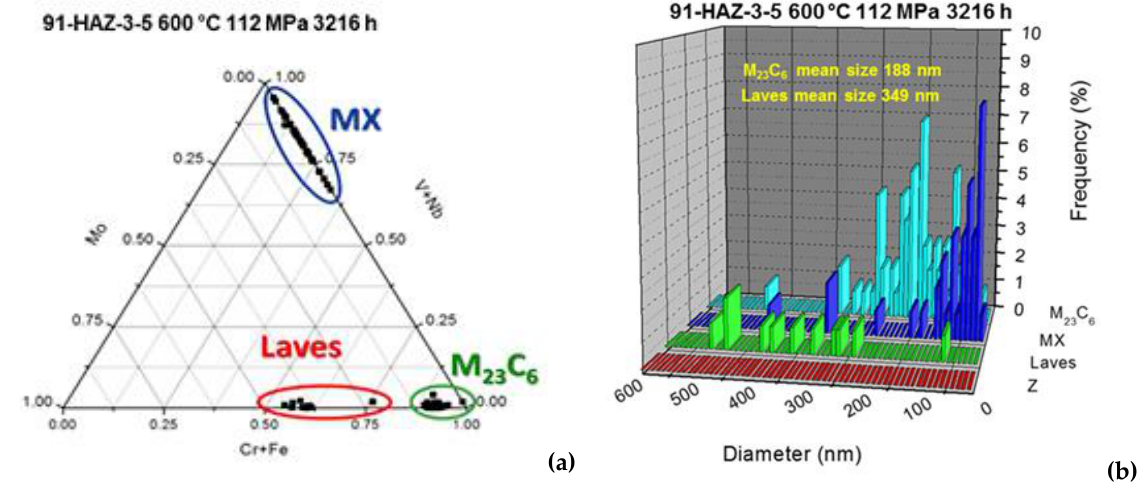
Figure A3. Failed crept cross-weld specimen 91-HAZ-3-5 600 °C 112 MPa 3216 h (sample B). Ternary diagram (a) and size distribution (b) (TEM analysis).